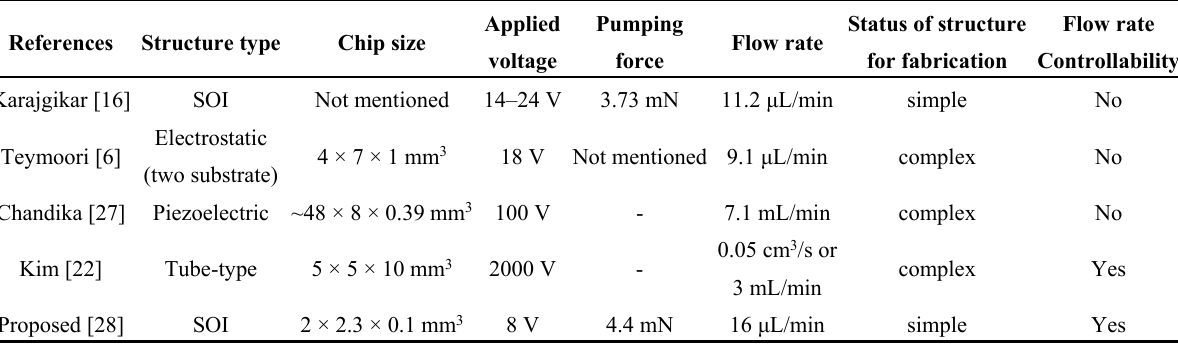
Table 6. Comparison of the proposed micropump structure with previous